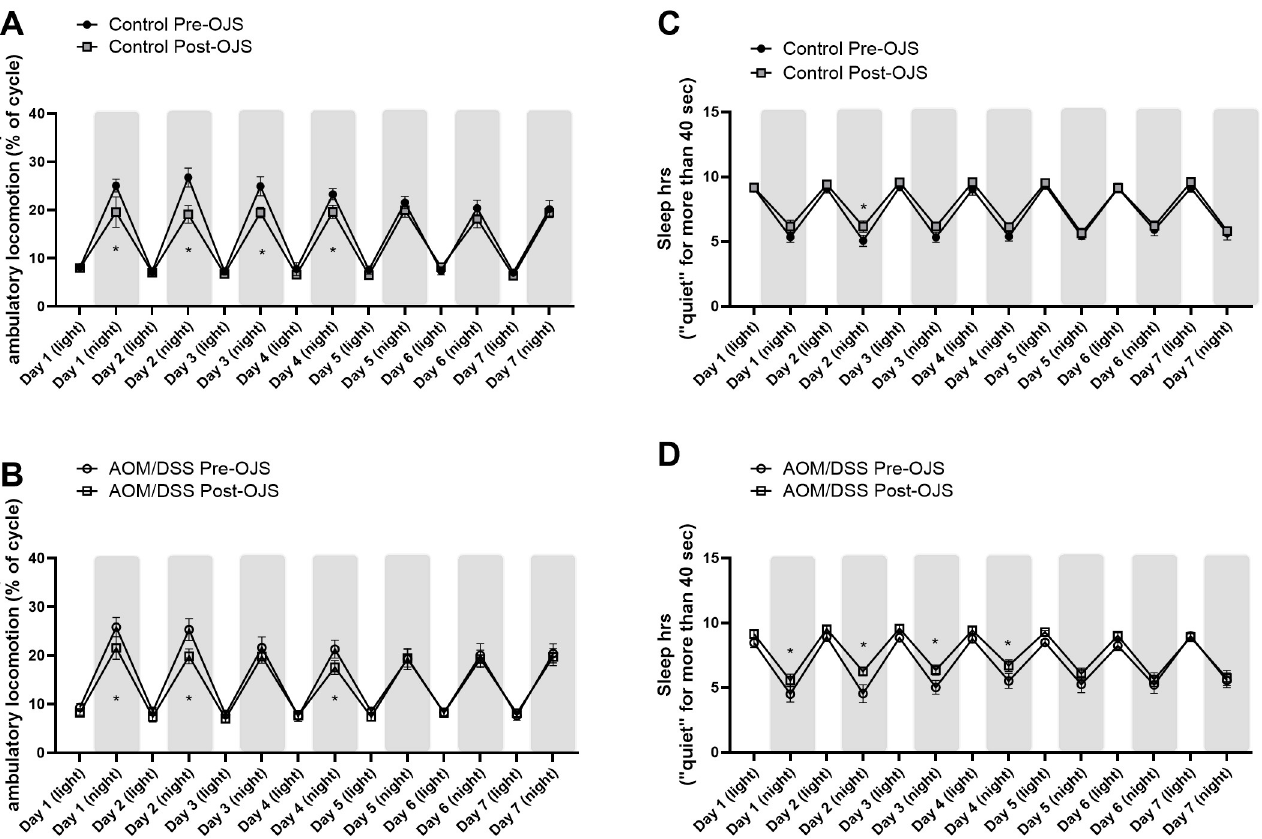
Fig 6. OJS decreases locomotor activity and increases sleep time during the night cycle in the AOM/DSS model. Behavioral phenotyping was achieved by use of the automated Promethion System. Percent time of the cycle that (A) Control non-cancer and (B) AOM/DSS mice spent walking. Total hours that (C) Control non-cancer mice and (D) AOM/DSS mice spent sleeping during the light and night cycle. � Indicates statistical significance between groups (p < 0.05) from two- way RM ANOVA Fisher LSD, n = 8/group.